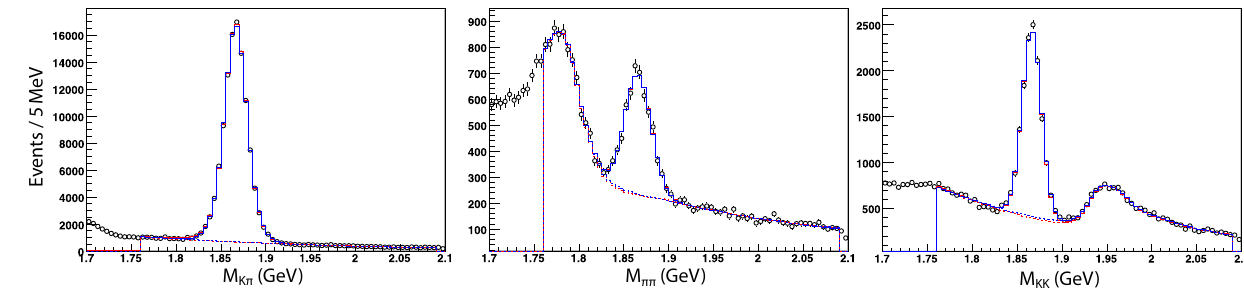
Fig. 210 FOCUS data ( dots ), original fits ( blue ) and toy MC parameterization ( red ) for D 0 → K − π + ( left ), D 0 → π + π − ( center ), and D 0 → π + π − ( right )